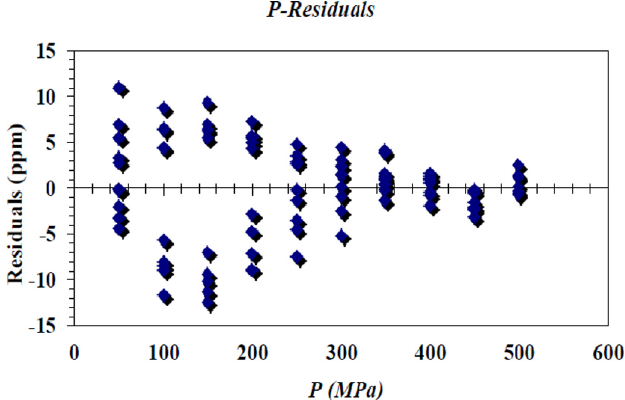
Fig. 5. Residuals in effective area of UUT from Linear fi t (AeL.F) and direct comparison to NIS pressure scale (Ae) for 5